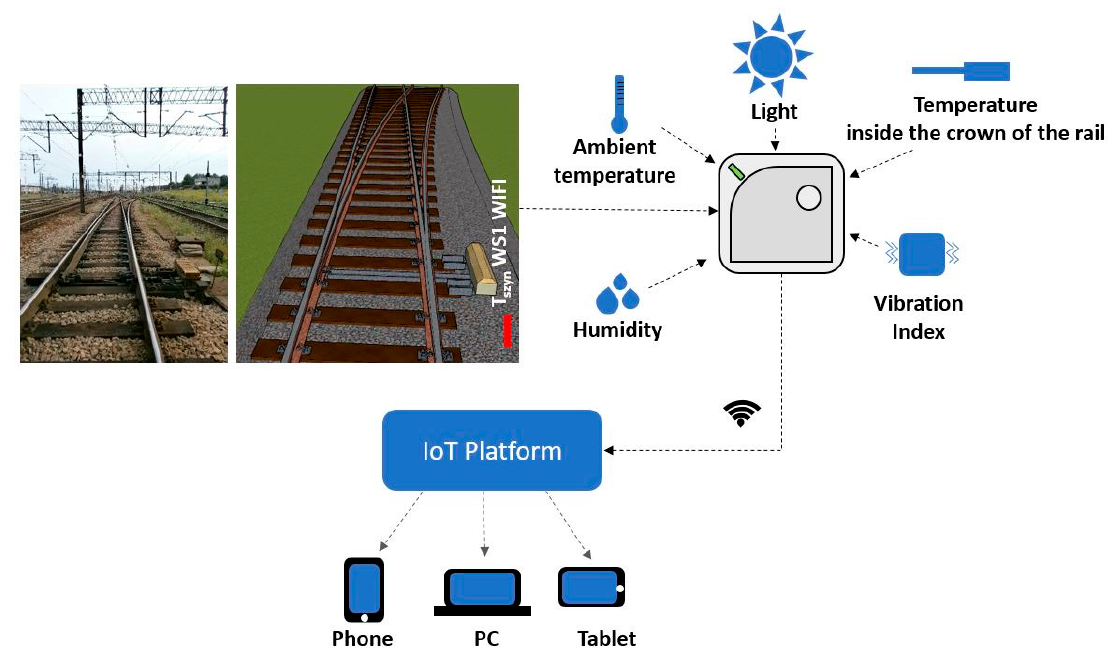
Figure 3. Scheme for conducting observations using measuring station T szyn WS1 WIFI.